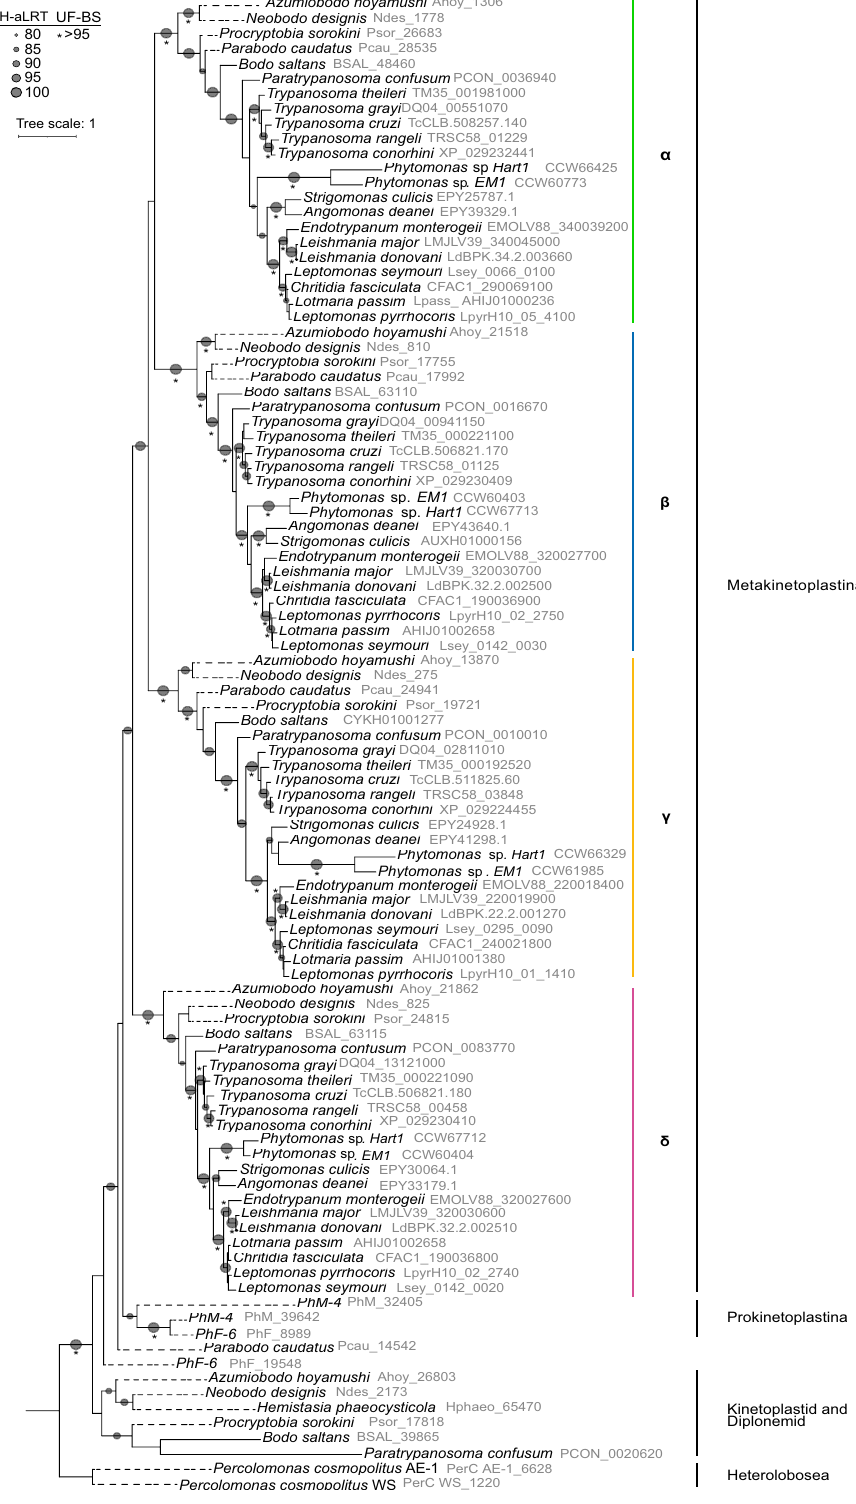
Fig. 4 AQPX phylogenetic tree of the Discoba supergroup. Phylogeny of AQPX proteins was reconstructed by maximum likelihood. Branch support was assessed by the ultrafast bootstrap (UF) approximation with 10,000 replicates and the SH-aLRT with 1000 replicates. Dashed lines represent transcriptome retrieved